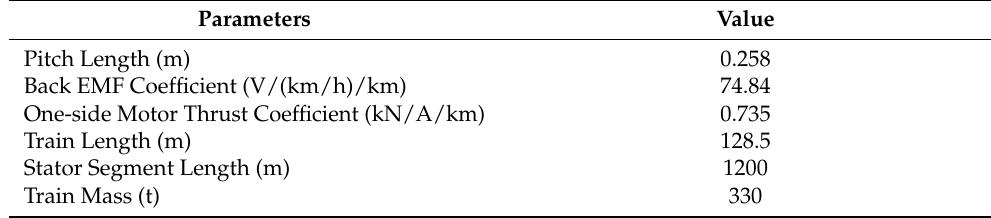
Table 1. The parameters of the LLSM and Maglev train in Simulink model.